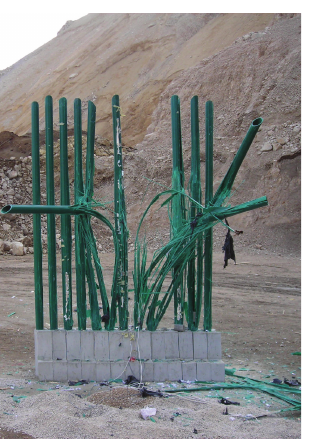
Figure 5: Pressure gauges setup.